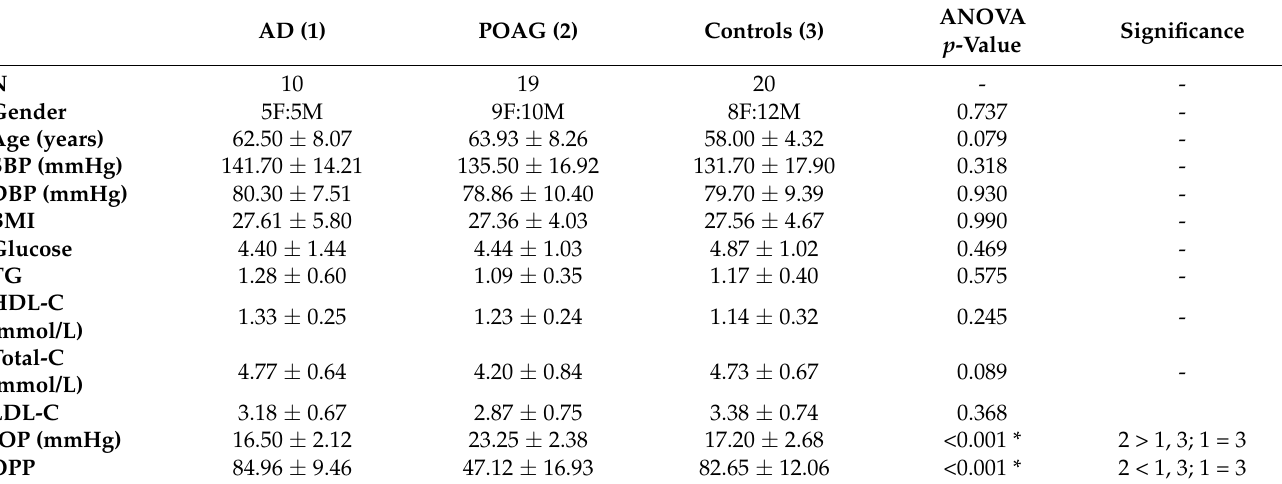
Table 1. Summary of systemic characteristics of the study